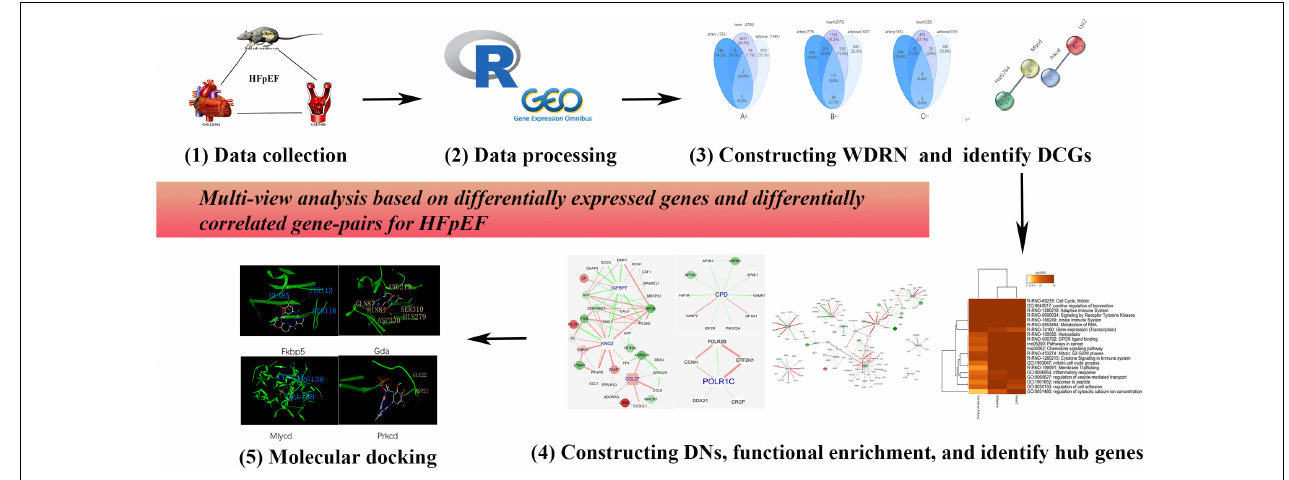
FIGURE 1 | The flowchart of this research. We proposed a multiple-tissue and multilevel comparative framework based on differentially expressed genes and differentially correlated gene pairs for heart failure with preserved ejection fraction